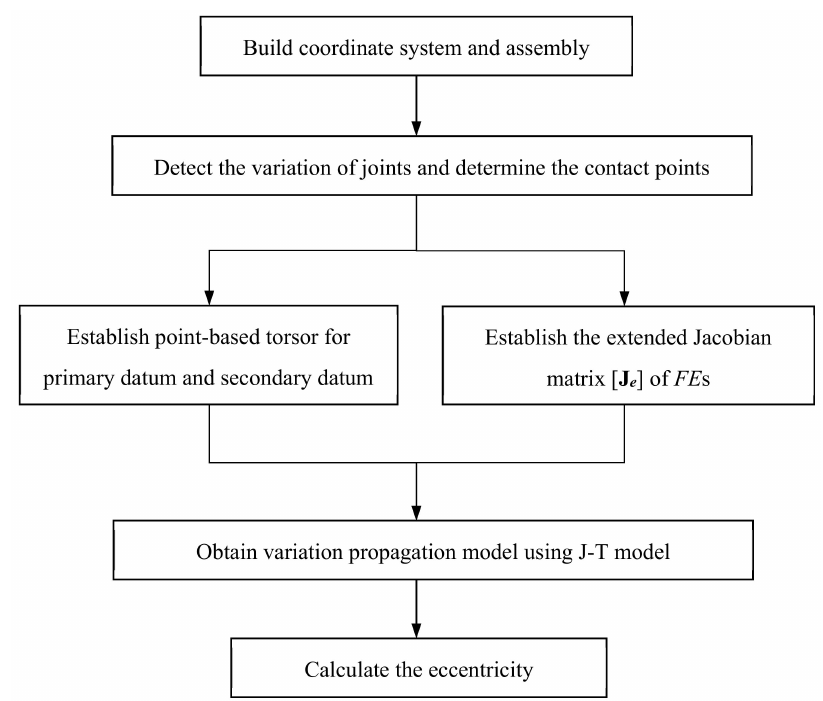
Figure 8. Point-based solution of partial parallel chain